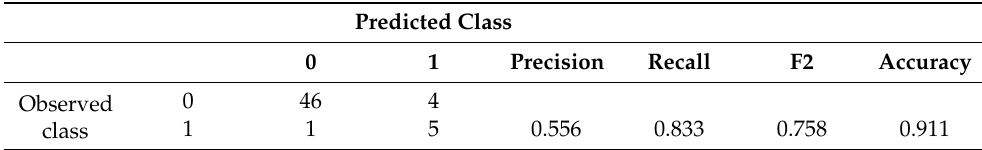
Table 8. Confusion matrix for the RF model. El Rubial off-stream reservoir. Predicted Class